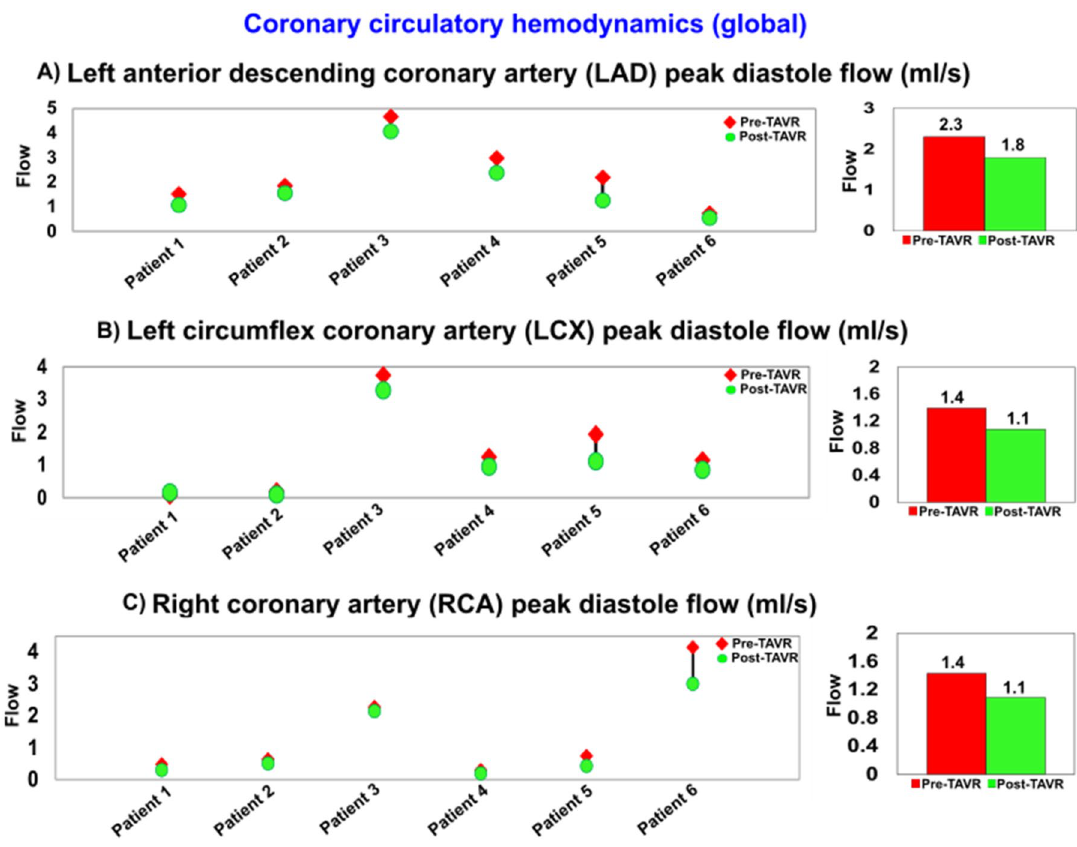
Figure 17. Changes in coronary circulatory hemodynamics in patients between baseline and 90-day post TAVR (N = 6). ( a ) Left anterior descending coronary artery peak diastolic flow; ( b ) Left circumflex coronary artery peak diastolic flow; ( c ) Right coronary artery peak diastolic